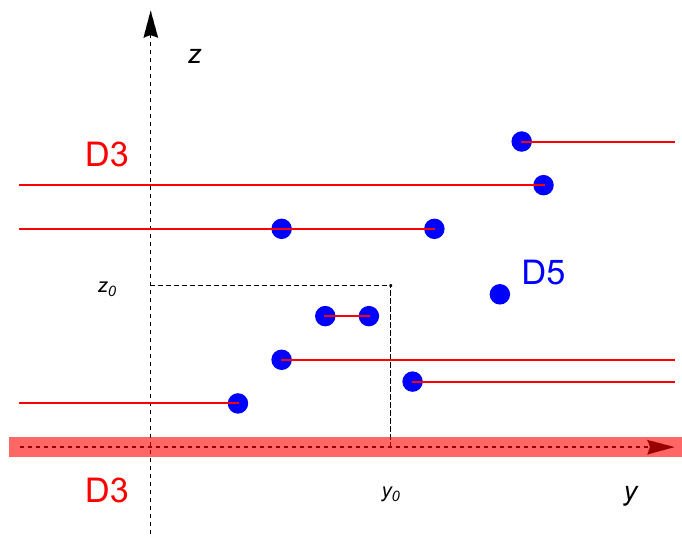
Figure 4 . The brane con(cid:12)guration corresponding to a generic point of the vacuum M vac . The thick red line along the y -axis represents the original color D3-branes. The blue dots are the D5-branes. Their relative separations in the y and z i directions are dictated by the vevs (cid:8) y (cid:12)nite and/or semi-in(cid:12)nite D3-branes can begin and end on the D5-branes. The precise numbers of these will be controlled by the asymptotic and ’t Hooft